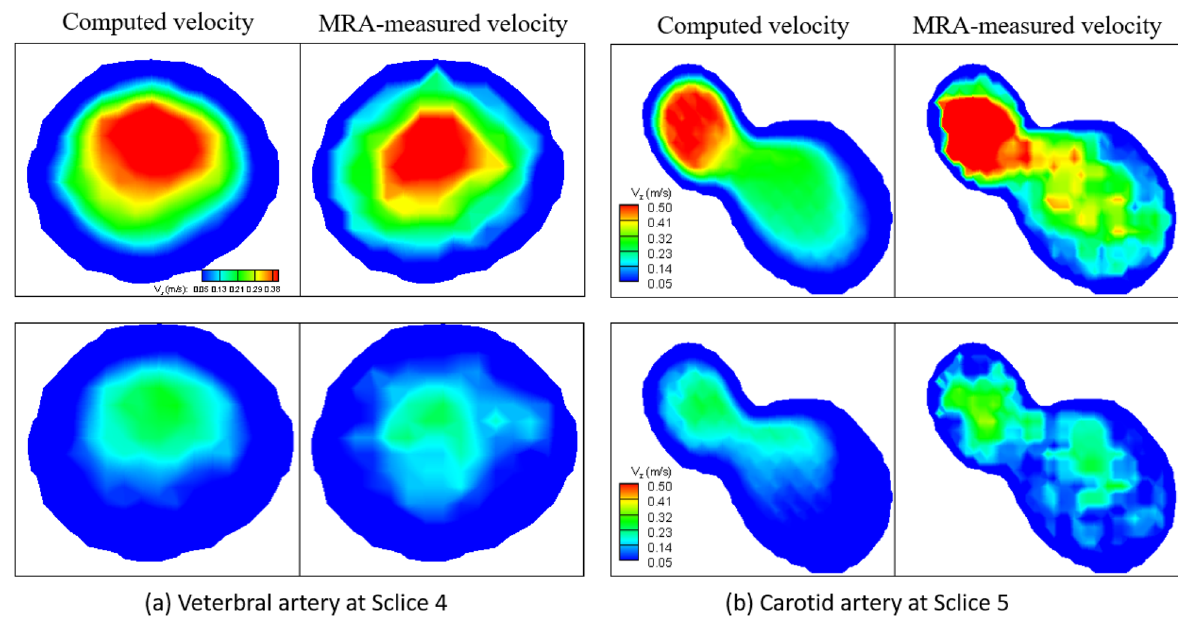
Figure 11. Comparisons of computed (left) vs. MRA-measured (right) velocity contours at (a) Slice 4 of vertebral artery at and (b) Slice 5 of carotid artery. On each panel, the top and bottom rows correspond to the peak systole and the end of diastole in a cardiac cycle.